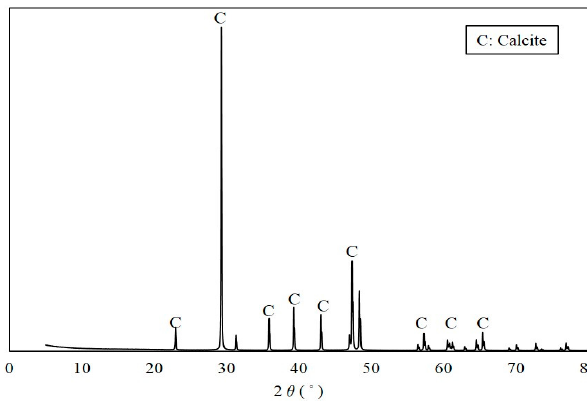
Figure 6. XRD pattern of CaCO 3 precipitated in urea–calcium lactate medium at 33 h.